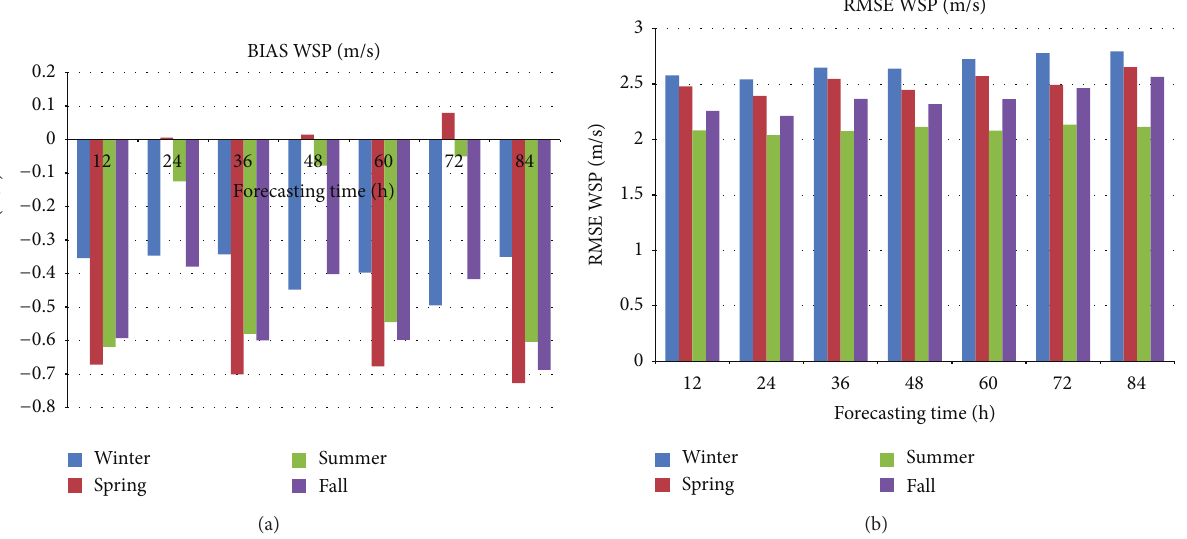
Figure 5: BIAS (a) and RMSE (b) for wind speed for the four seasons.